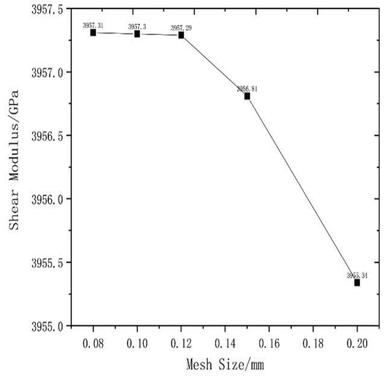
Effects of mesh size on modulus.